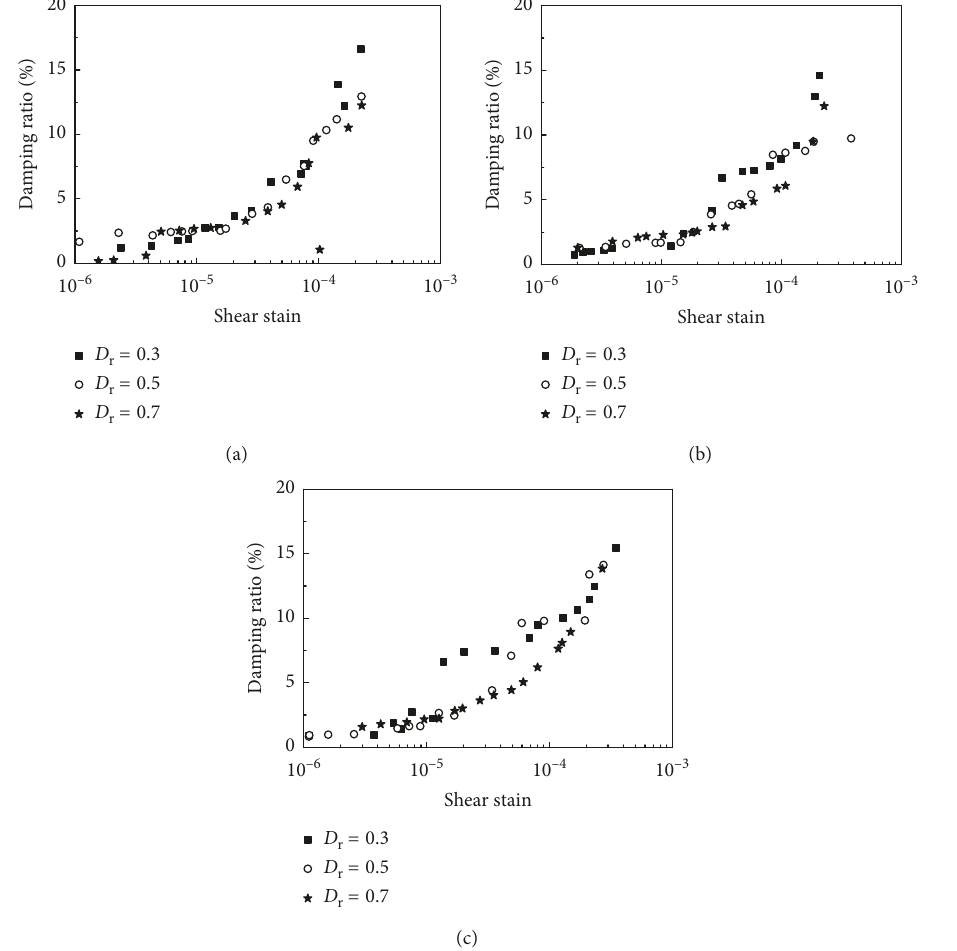
Figure 7: Effect of the damping ratio on the λ - c curve of steel slag: (a) σ